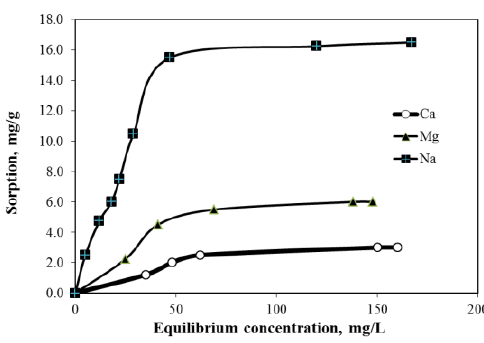
Fig. 2. Adsorption isotherms of Ca, Mg and